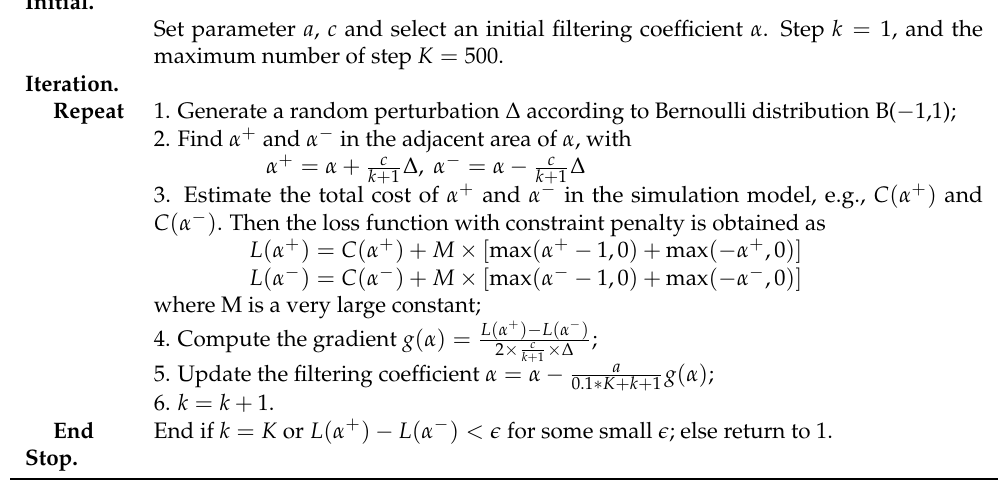
Table 2. The framework of Simultaneous Perturbation Gradient Approximation (SPSA) algorithm to the hybrid system configuration and